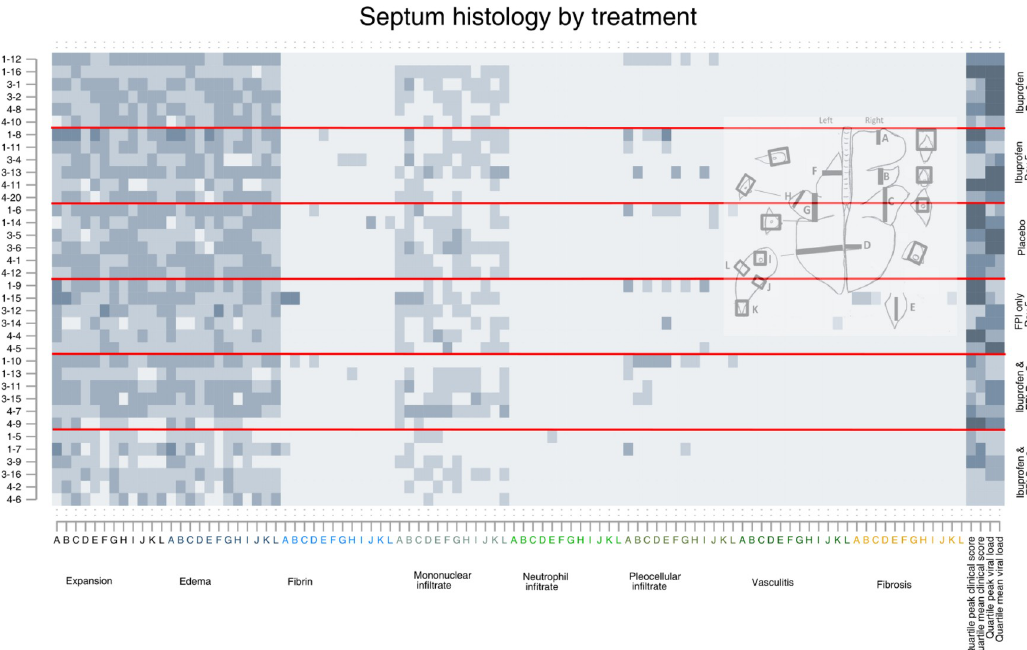
Fig 6. Septum histology findings by drug treatment group. Each row represents an individual calf, each letter represents a slide, the x-axis colors indicate a different specific histological finding. The shading of each pixel represents the severity of the finding on a scale of 0 (light) to 3 (darker). On the y-axis the first number represents the batch/replicate number, the number following the dash the ear tag for the individual calf. The horizontal red lines divide the treatment groups. The last four columns represent quartiles (first lightest, fourth darkest) of mean peak and clinical scores and mean peak viral loads measured by nasal